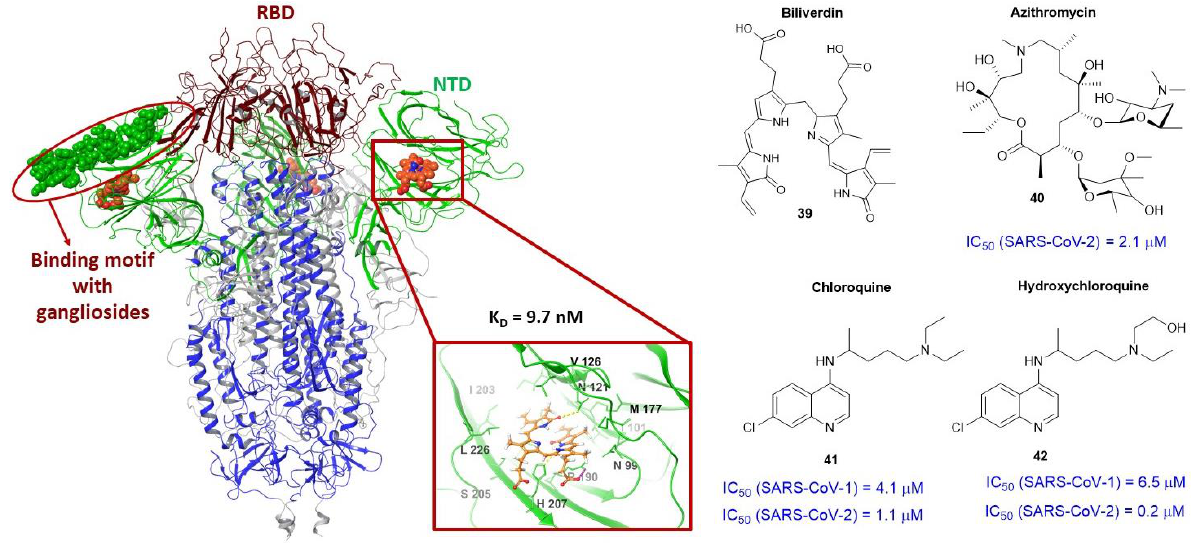
Figure 14. Structures binding in the NTD domain of S-protein. Biliverdin is shown in orange and hydrogen and salt bridges are shown in yellow and purple dotted lines.